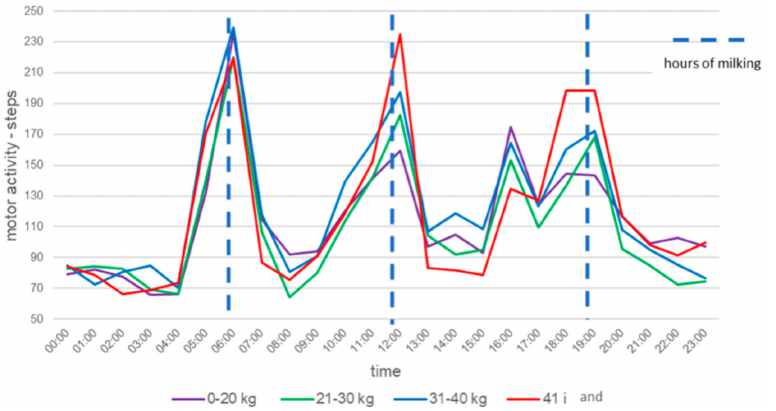
Figure 10. The twenty-fou- hour activity of cows generated on the basis of data that were achieved from the Japanese system GYUHO.